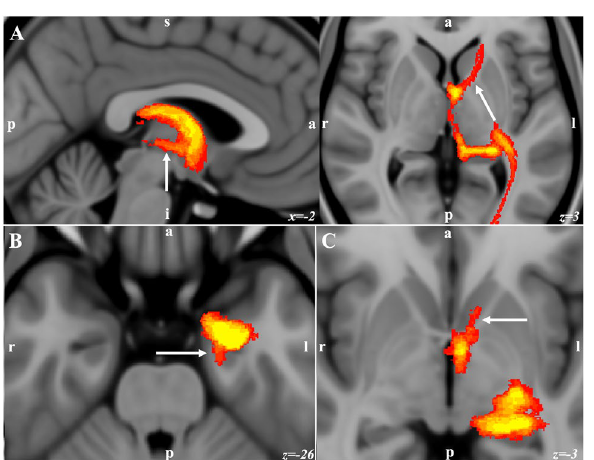
Figure 5. Population connectivity maps of the amygdala clusters. ( A ) The lateral cluster also showed stronger connectivity with sensory areas including parietal, occipital, and posterior temporal areas (arrows) ( B ) The basal and lateral clusters also showed stronger connectivity through the parahippocampal radiation of the cingulate bundle (white arrow in sagittal view), with the temporal pole (black arrow in sagittal view), and through the amygdalotectal pathways with the colliculi. ( C ) The lateral cluster had stronger connectivity through the subcaudate white matter and ventromedial part of the uncinate fascicle with the PFC (arrow).